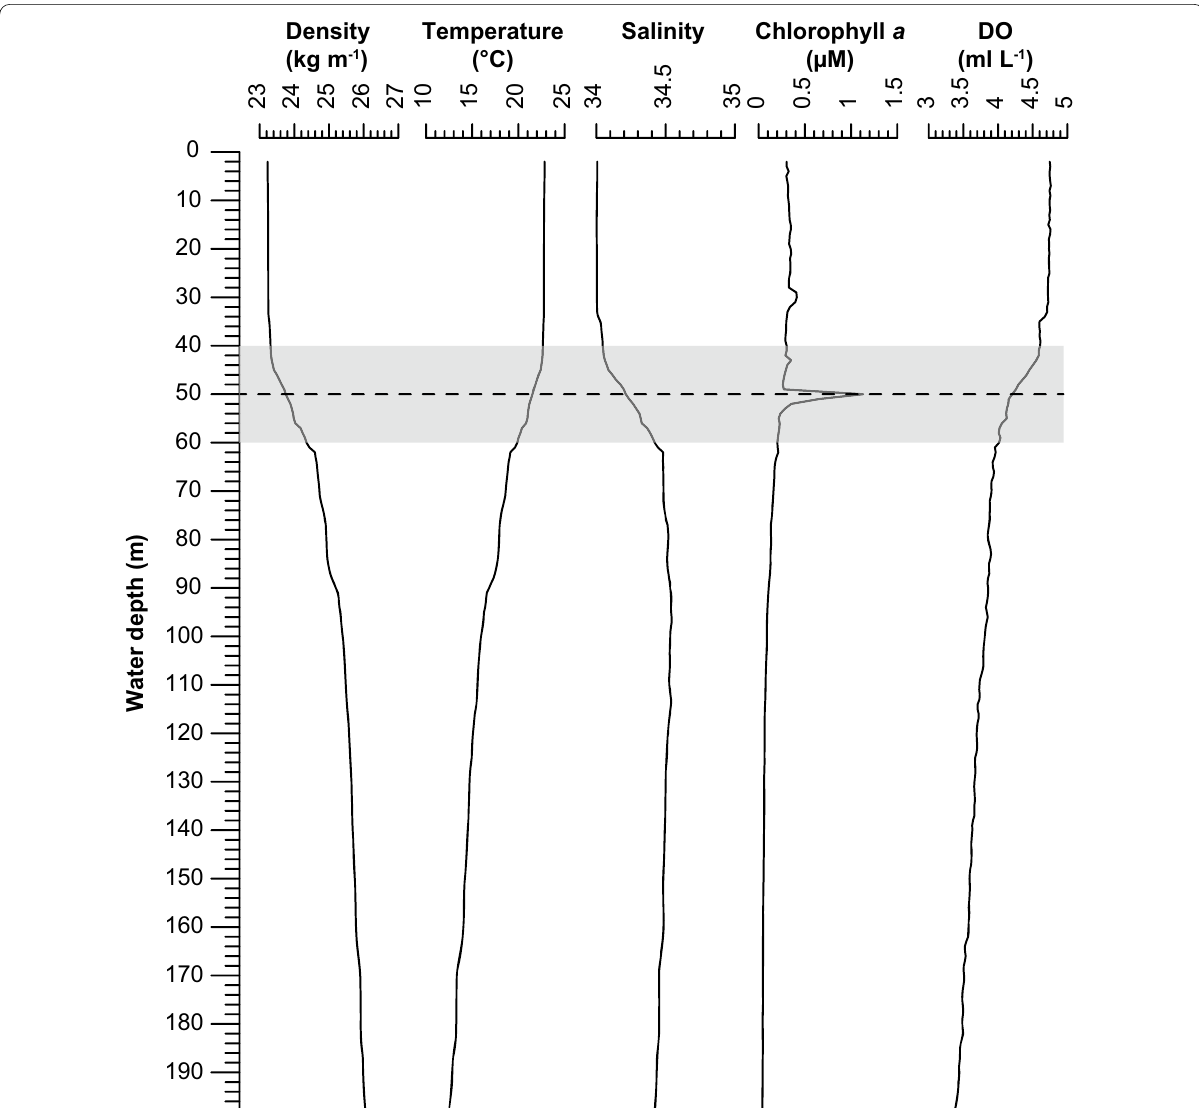
Fig. 2 Hydrographic conditions at the plankton tow site in Suruga Bay, Japan. A gray zone in a indicates the thermocline/halocline/pycnocline, while a dashed line indicates the deep chlorophyll maximum